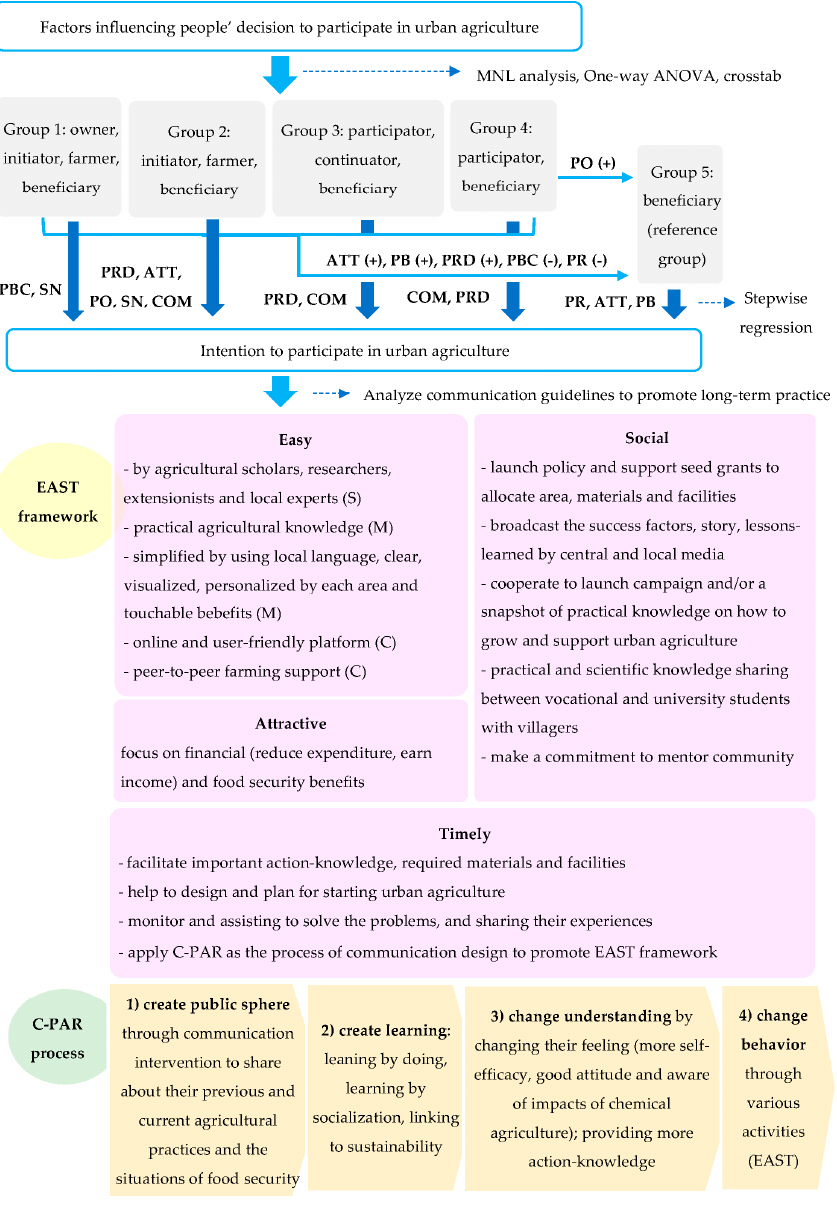
Figure 4. Communication guidelines to promote long-term practice of urban agriculture.